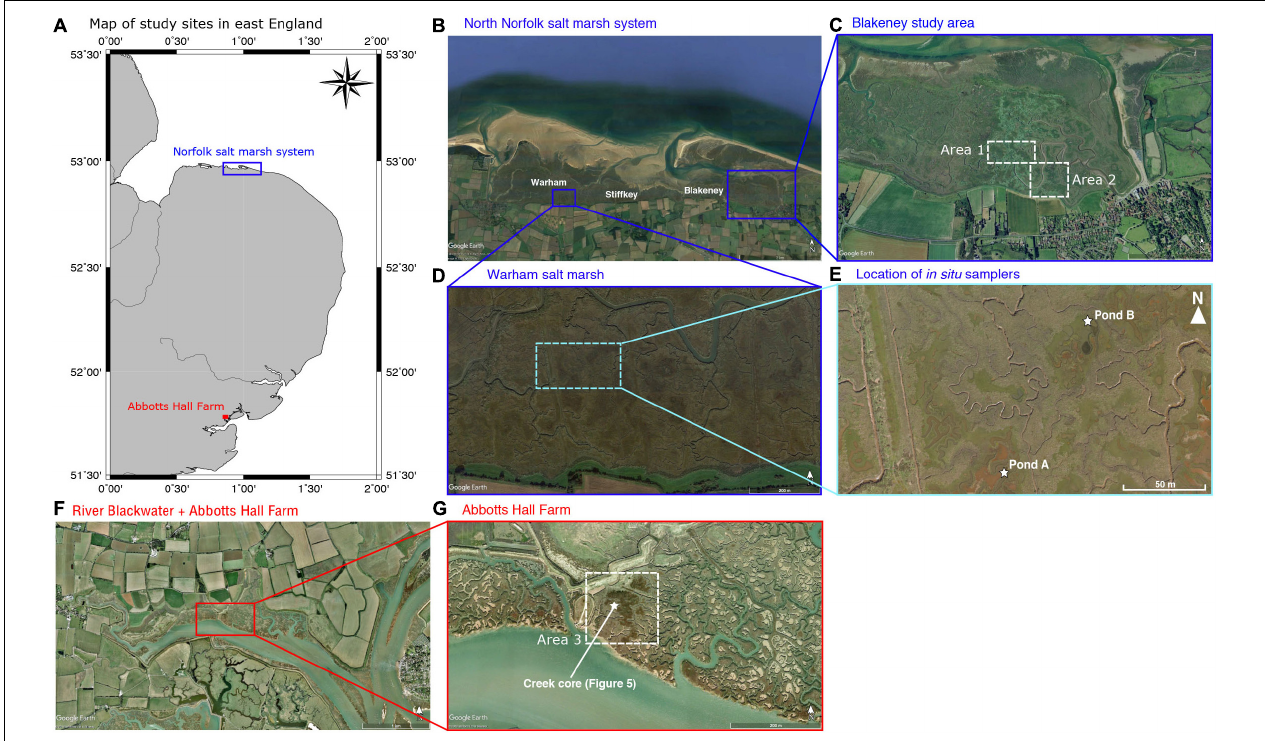
FIGURE 1 | (A) Map of east England showing the Norfolk salt marsh system and Abbotts Hall Farm nature reserve (Essex wildlife trust). Scale from latitude/longitude lines. (B) Google Earth satellite imagery (24-09-17) of the Norfolk salt marsh system comprising Warham marshes, Stiffkey marshes and Blakeney marshes (labeled). Cores in the data compilation were taken throughout this area. The blue box denotes the location of (D) . Image credit: Google Earth, Image 2018 DigitalGlobe (C) Google Earth Satellite imagery (31-12-1999) of Blakeney salt marsh. Area 1 and 2 correspond to the mapped areas in Figures 7 and 8 respectively. (D) Google Earth satellite imagery (10-01-2019) of the Warham salt marsh area where in situ samplers are installed. Light blue box indicates location of (E) . Image credit: Google Earth. (E) Location of in situ samplers (Pond A and B) in Warham salt marsh. (F) Google Earth satellite imagery (06-11-2006) of the River Blackwater and the location of Abbotts Hall Farm nature reserve. Red box denotes the location of (G) . Image credit: Google Earth, 2018 Infoterra Ltd & Bluesky. (G) Google Earth satellite imagery (06-11-1999) of Abbotts Hall Farm salt marsh system. Area 3 corresponds to mapped area in Figure 9 . White star denotes location of core taken in Figure 5 . Image credit: Google Earth, 2018 Infoterra Ltd &